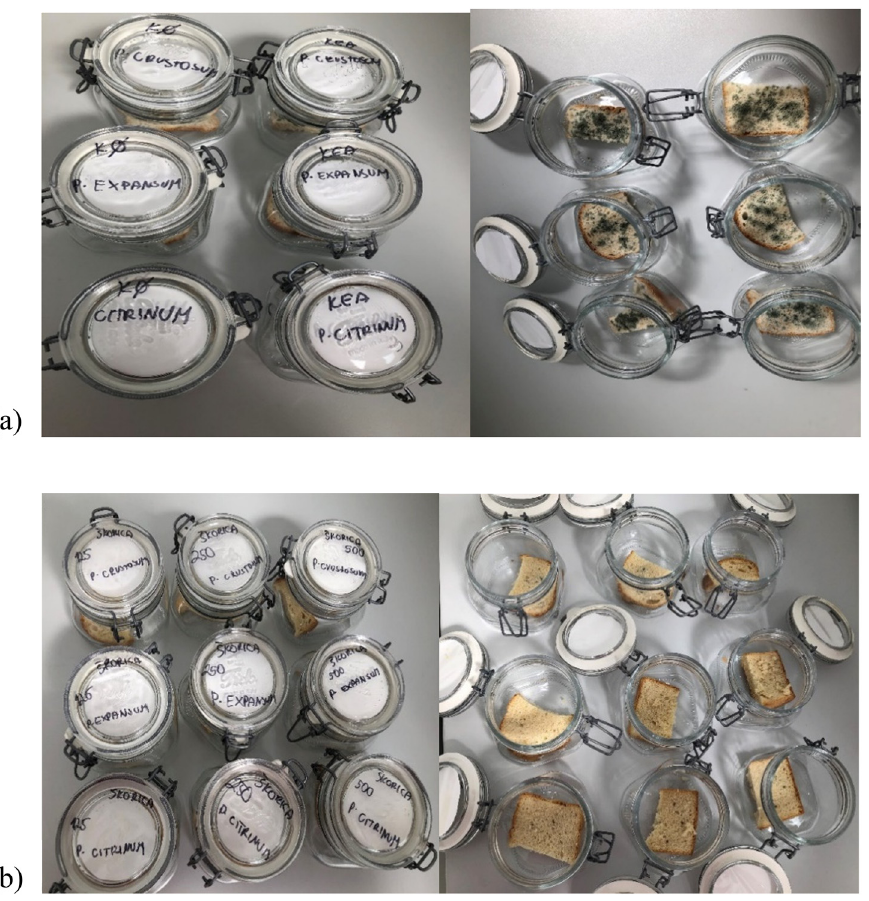
Figure 1: In situ antifungal assessment of bread inoculated with Penicillium crustosum, P. expansum, and P. citrinum in vapour phase. ( a ) control samples of bread; ( b ) bread inoculated with P. crustosum, P. expansum, and P. citrinum with the CCEO in concentration of 125, 250, and 500